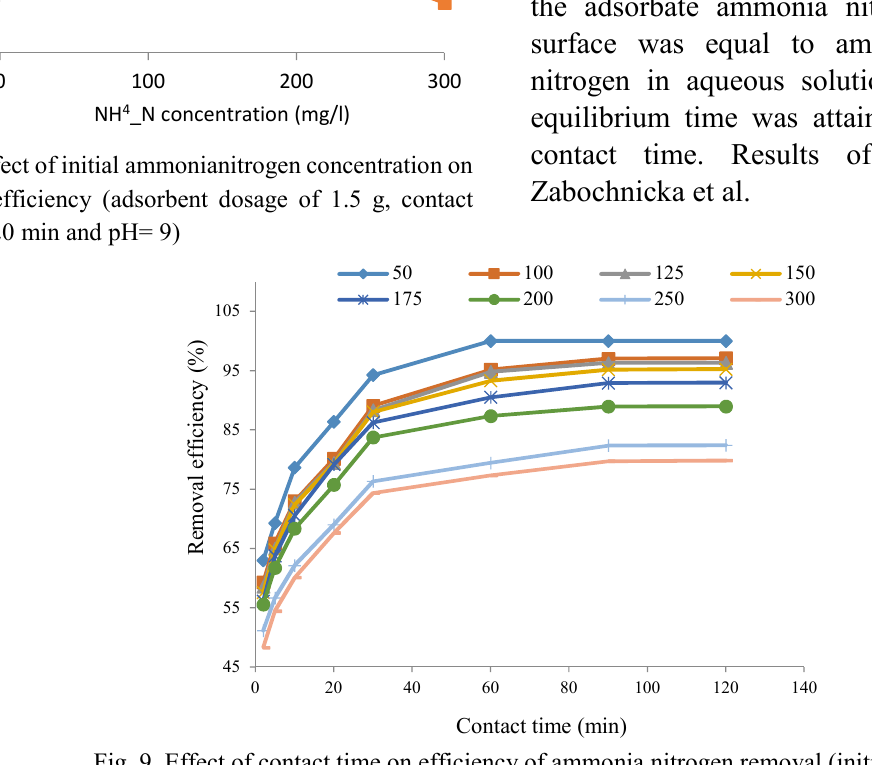
Fig. 9. Effect of contact time on efficiency of ammonia nitrogen removal (initial ammonia nitrogen concentration of 50-300 mg/L, adsorbent dosage of 1.5 g and